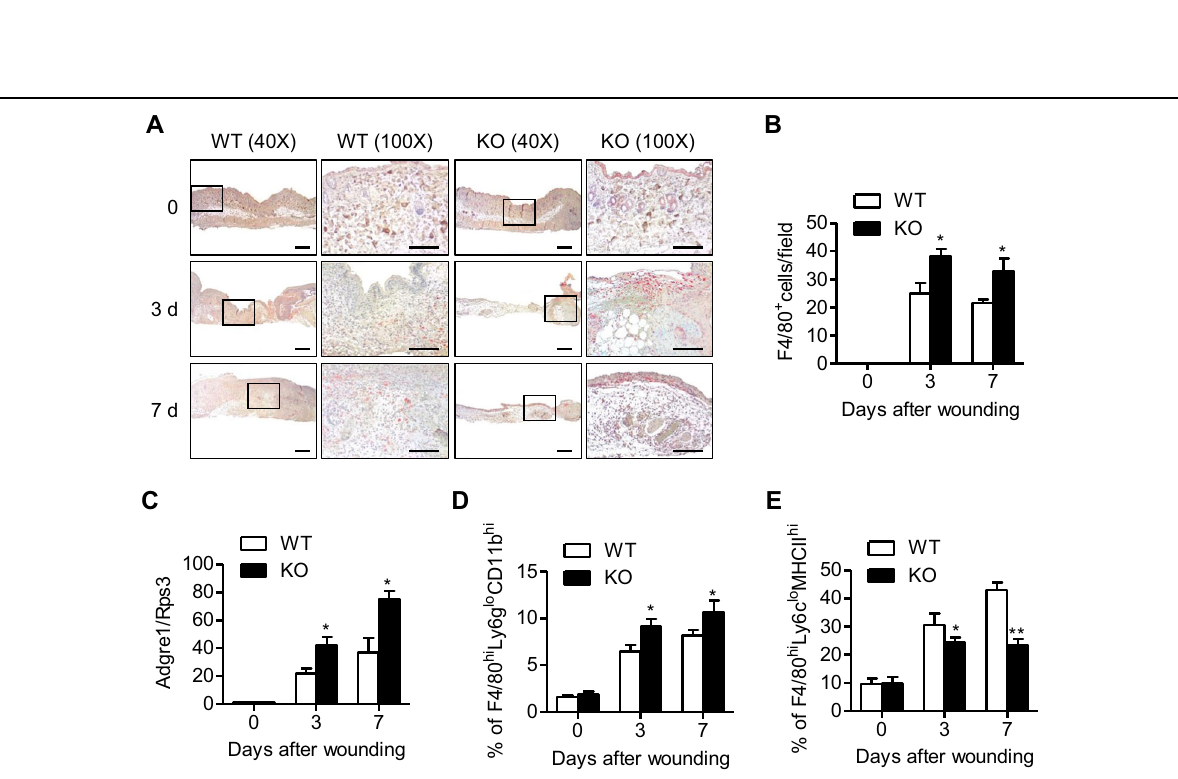
Fig. 3 Increase in macrophage in fi ltration into wound sites in mS6KO mice. a Immunohistochemistry was used to identify in fi ltrating macrophages (F4/80 + cells) at 0, 3, and 7 days after injury. Bars = 50 μ m. b F4/80-positive macrophages were counted in wound sections. c The mRNA level of F4/80 ( Adgre1 ) in the wound site was determined by real-time RT-PCR ( n = 8). d , e Single-cell suspensions were prepared by enzymatically digesting and gently dissociating skin wounds. After excluding dead cells, the cells were analyzed by fl ow cytometry to identify all macrophages (F4/80 hi Ly6g lo CD11b hi ) and M2 macrophages (F4/80 hi Ly6c lo MHCII hi ) ( n = 5 – 6). Values represent the mean ± SEM. * p < 0.05 and ** p < 0.01 vs.